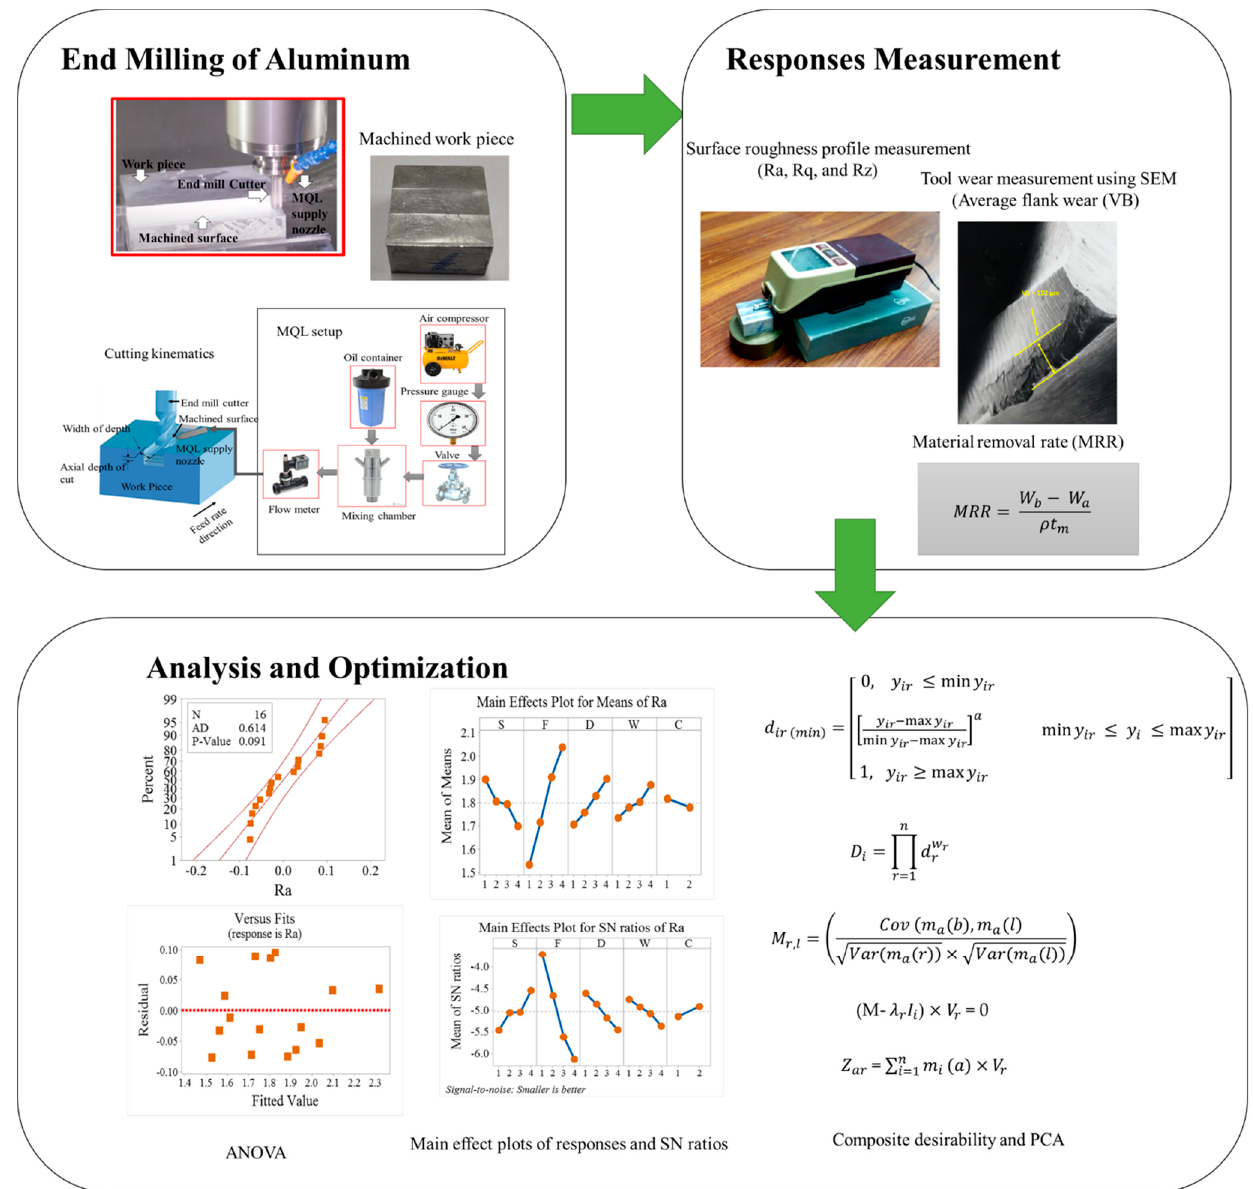
Figure 5. Research